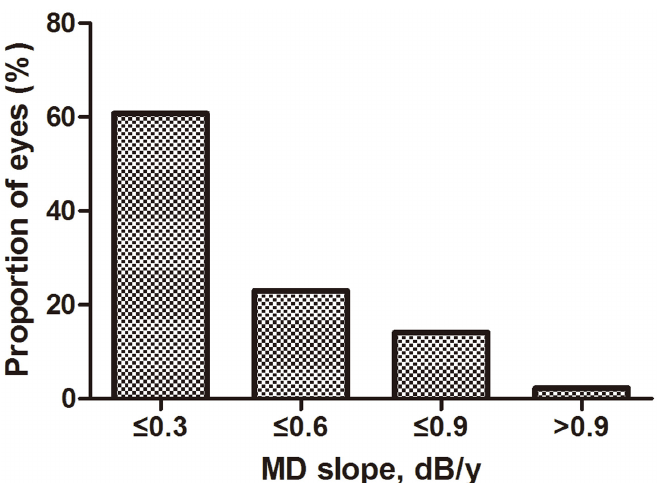
Fig 1. A distribution of the mean defect slope in the study. The mean value and the median of the mean defect slope are 0.284 ± 0.314 dB/y and 0.215dB/y, respectively. Patients identified as fast progression at the cutoff threshold of 0.30 dB/y were observed in 39.26% (106/270) of the study